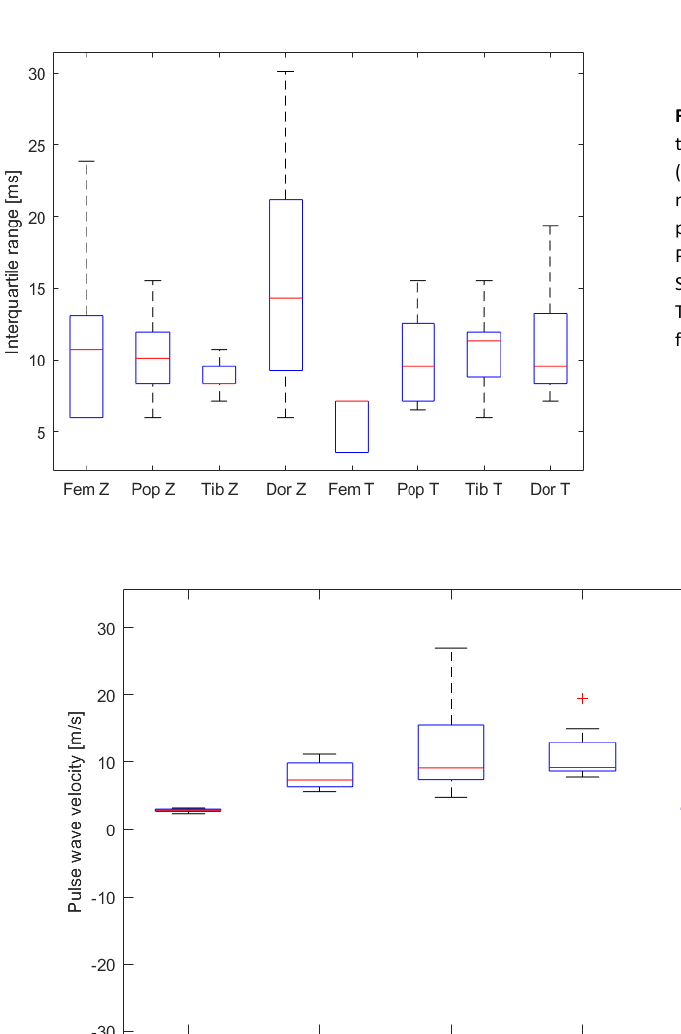
Figure 7: Bland-Altman plots for pulse wave velocity estimates for IPG method versus tonometry, showing the difference between the paired IPG and tonometer estimates versus the paired means. The bias is shown in the solid line and the 95% limits of agreement in dashed lines. *This pair had a negative mean value due to a large negative value for the tonometer estimate. In this case, the IPG estimate only was used as the mean